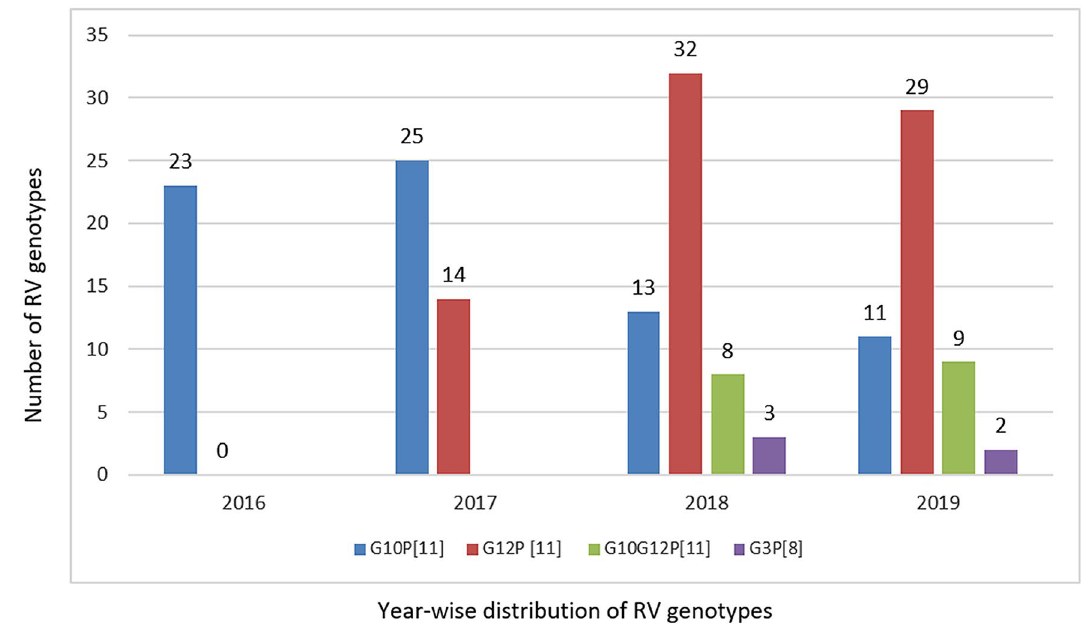
Figure 1. Year wise distribution of RV genotypes among neonates. This is a clear decline in G10P[11] in the past 3 years (2017–2019). G12P[11] detection rate was increased during the year